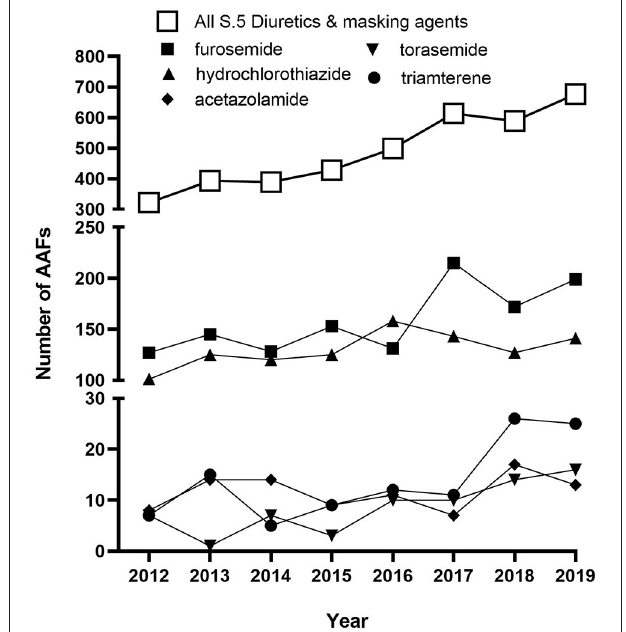
FIGURE 2 | Historic global trends for AAFs for substances in the class of S5. Diuretics and masking agents (open squares) and particular diuretics (closed symbols) as reported in the 2012–2019 Anti-Doping Testing